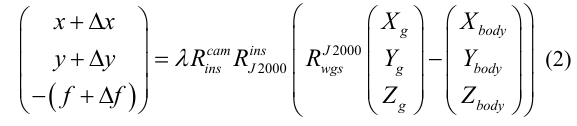
 represents the object space coordinate in where   , , the WGS84 coordinate system, represents the satellite’s coordinate in the J2000 coordinate system, which is obtained by the afterwards orbit determination technology. represent the installation matrix from the star trackers to the camera coordinate system, rotation matrix from the J2000 coordinate system to the star trackers’, and rotation matrix from the WGS84 to the J2000 coordinate system.   , , is